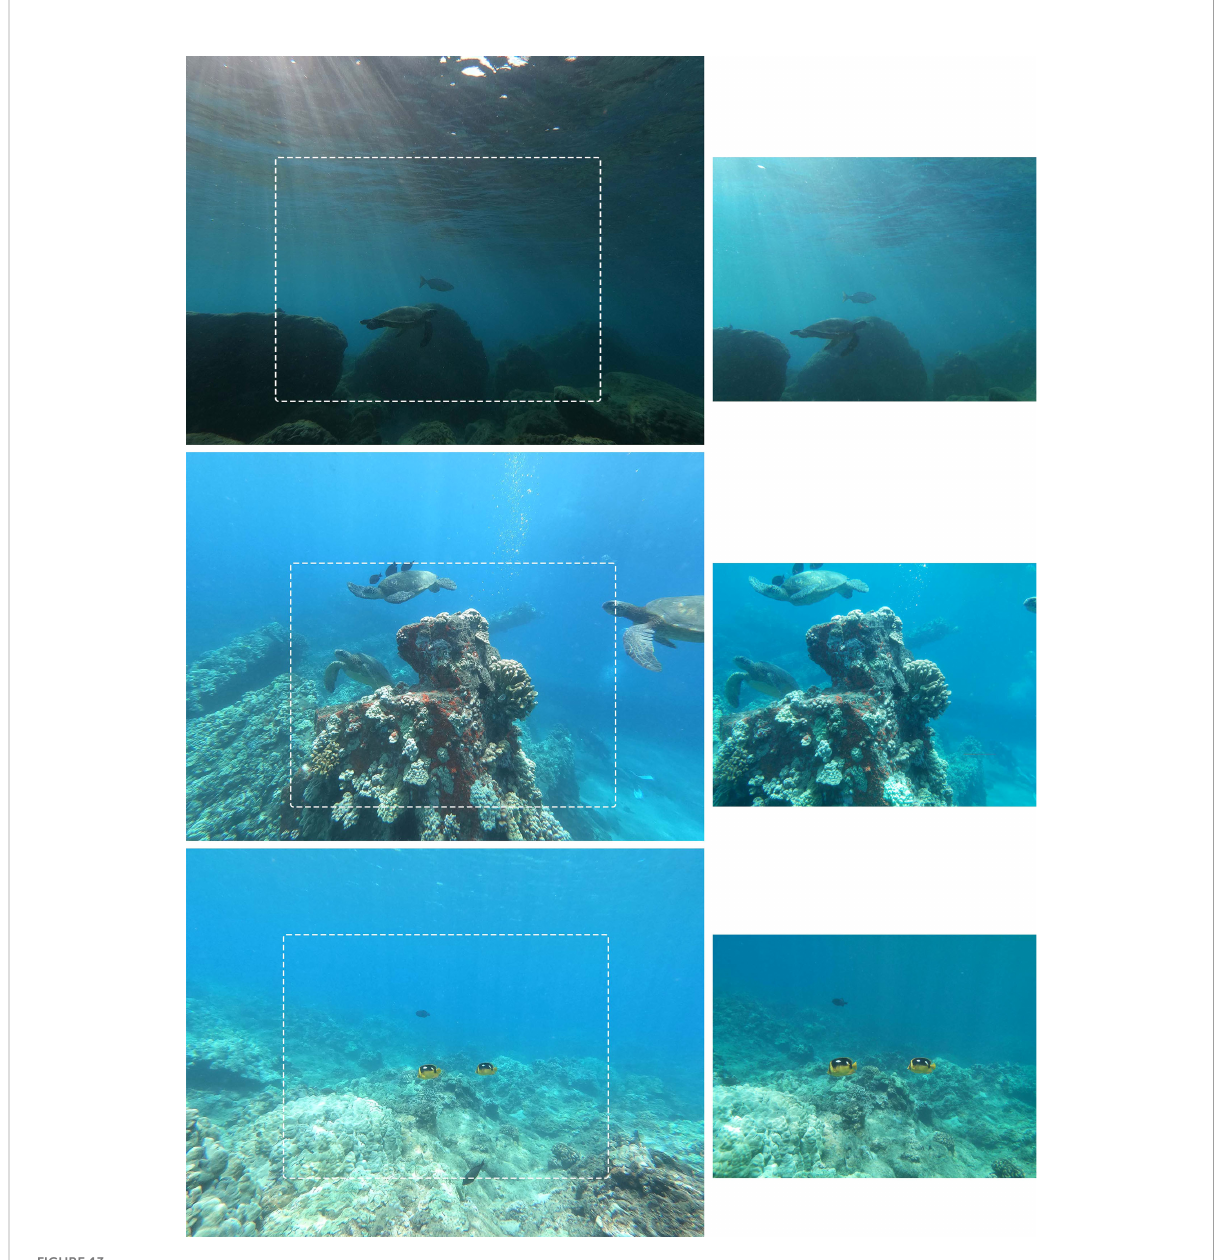
FIGURE 13 Images captured by GoPro7 are on the left; images captured by Maka Niu are on the right. Both devices were set to full automatic control and had post-processing disabled. The GoPro diagonal fi eld of view is 100° and the images are 4000x3000 pixels. The Pi Camera Module V2 diagonal fi eld of view is 62° and the images are 2592x1944 pixels. A white dotted rectangle in the fi gure marks the approximate cropping of the GoPro images that would result in the equivalent Maka Niu images. Since both the fi eld view and the pixel count of the Maka Niu images are about a third of those of the GoPro, the cropped images would have roughly equivalent pixel